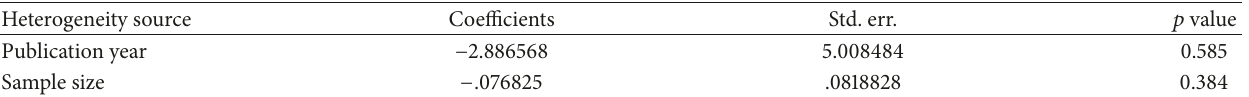
Table 2: Meta-regression analysis of factors with heterogeneity of the prevalence of depression among diabetic patients in Ethiopia, 2018. Heterogeneity source